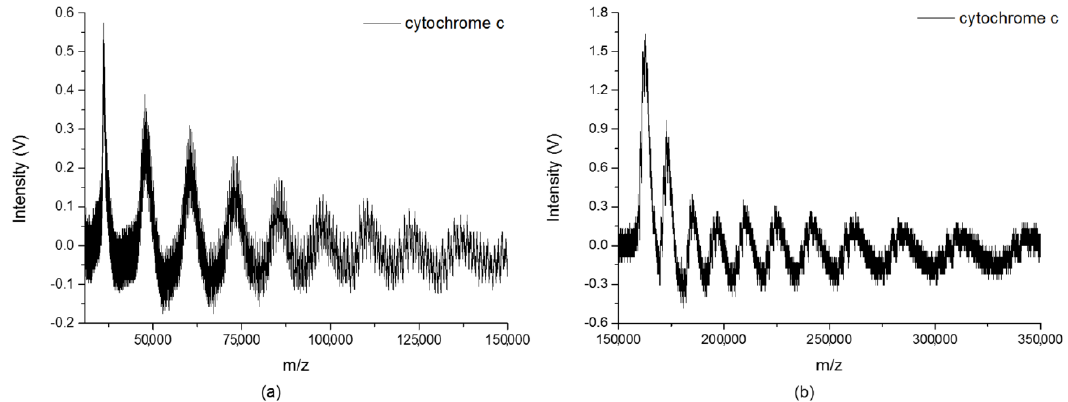
Figure 4. ( a ) Cytochrome c clusters in low-mass region. ( b ) Cytochrome c clusters with m / z from 150 kDa to 350 kDa.